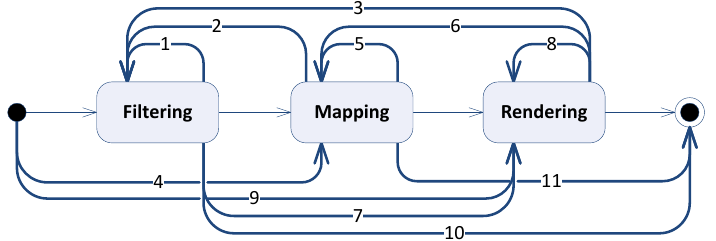
Figure 1. Unified Modeling Language (UML) state diagram depicting stage transitions of the traditional visualization pipeline (normal transitions) and those added by the generalized visualization pipeline (bold transitions, referring to Table